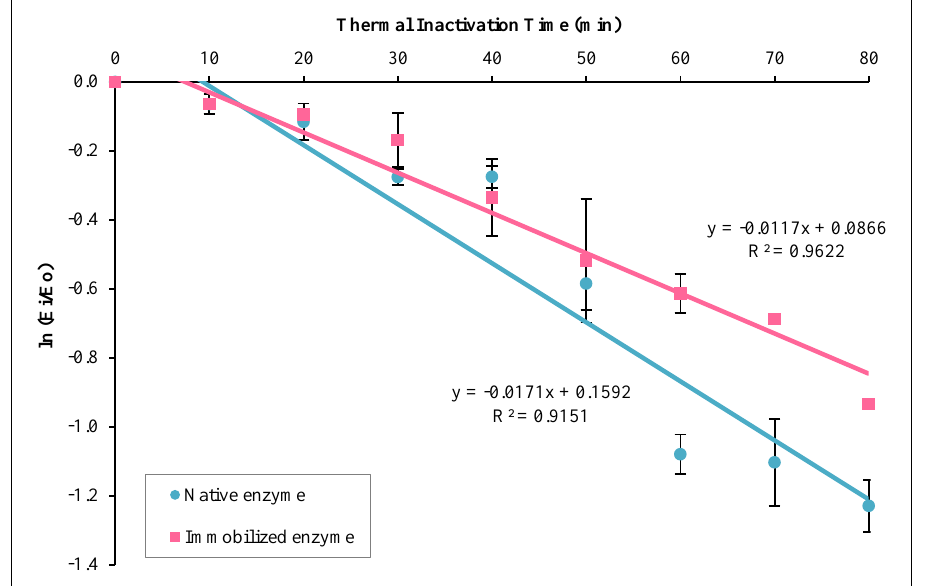
Figure 7. First-order inactivation rate plot of native and immobilized enzymes (mean ± SD; n = 2; p < 0.05) Table 4. t ½ and ΔG i values for native and immobilized A. fumigatus α-amylase on different matrices Half life (t 1/2 ) Matrix